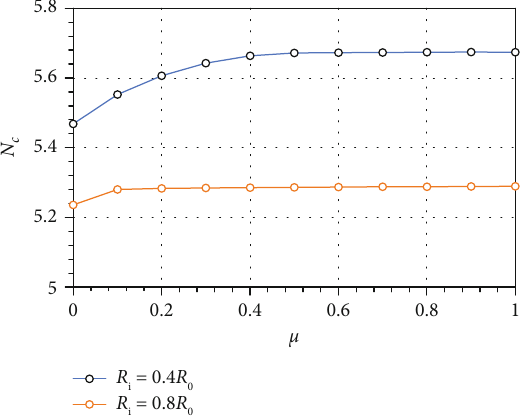
Figure 5: Variation curve of N